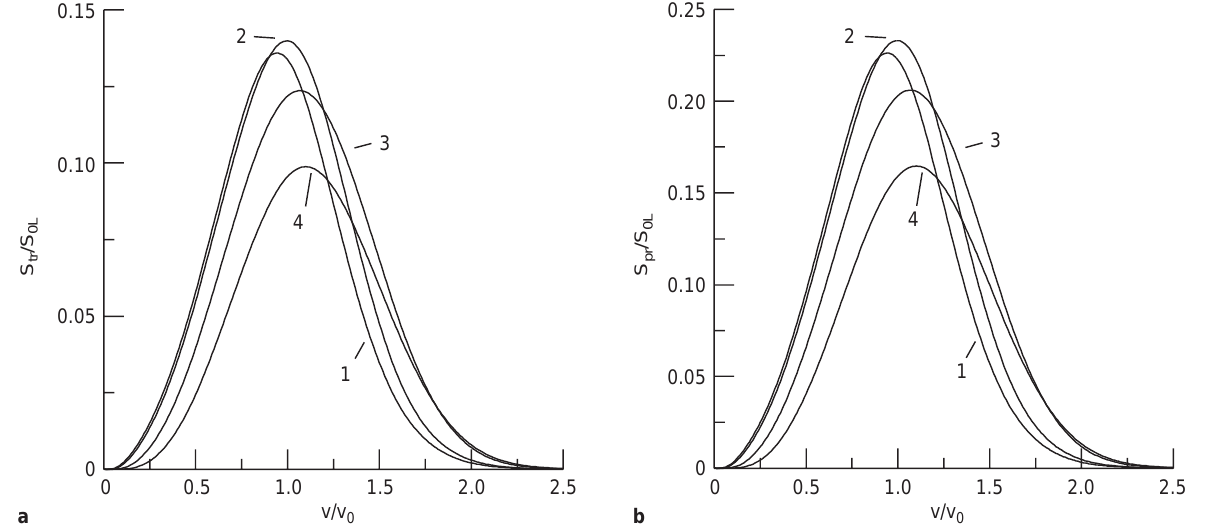
Fig. 5a, b. Energetic spectrum of a trapped and b precipitating energetic electron flux at low altitude for strong di(cid:128)usion for di(cid:128)erent u values. D v = v 0 (cid:136) 0 : 6 ; u (cid:25) 0 : 18 (cid:14) ; u (cid:25) 0 : 2 (cid:14) ; u (cid:25) 0 : 32 (cid:14) ; u (cid:25) 0 : 5 (cid:14) ; other parameters are as in 1 2 3 4